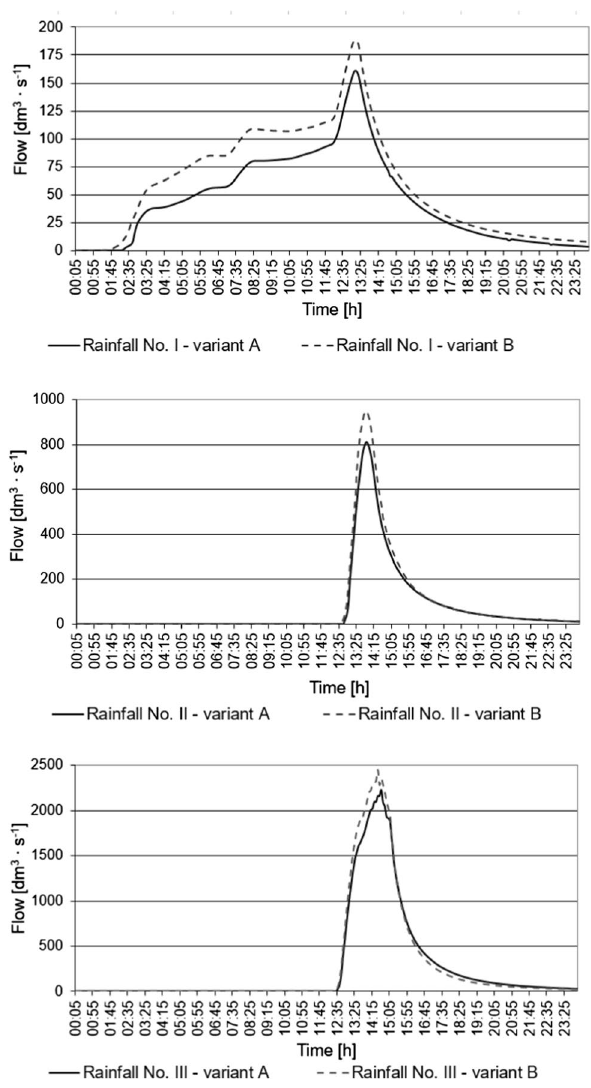
Fig. 7 Velocity of flow change in time for different variants of rain for the real surface and after the surface